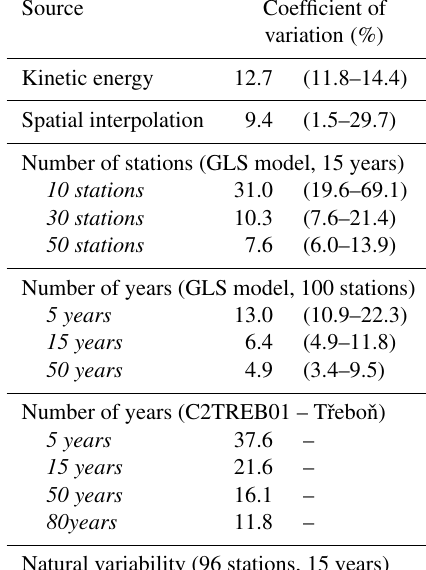
Table 2. The coefficient of variation (CV) for the R factor estimated by considering different formulas for kinetic energy, spatial interpo- lation methods, record length, and spatial coverage. In the second column, the average CV for all considered stations is given; the last two columns indicate the range of the CV from all stations in the “validation